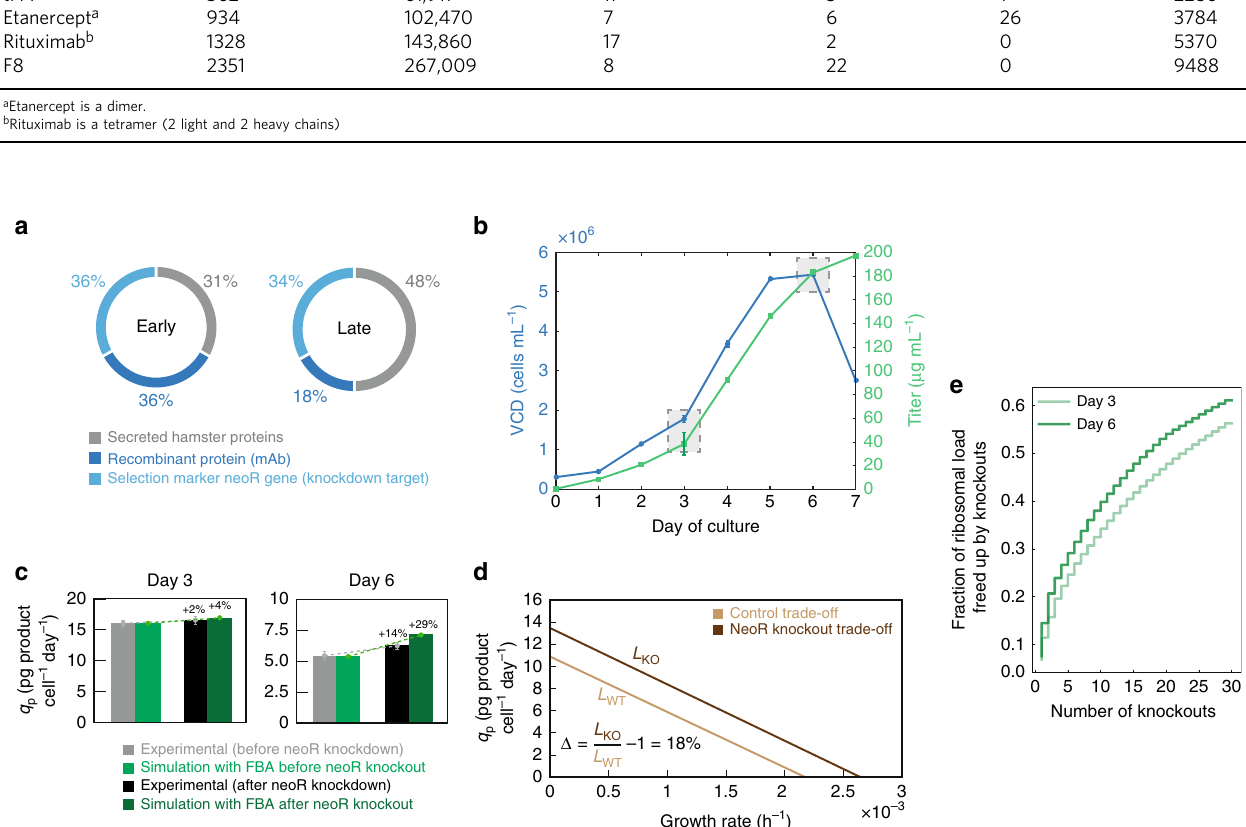
Fig. 5 iCHO2048s recapitulates experimental results of neoR knock-down in silico. a Ribosome occupancy was measured with ribosomal pro fi ling during early (left) and late (right) exponential growth phases 12 . b Time pro fi les are shown for viable cell density (VCD) and titer in experimental culture. Shaded boxes indicate the time points corresponding to early (day 3) and late (day 6) growth phases. c Flux balance analysis was used to predict speci fi c productivity ( q p ) with the iCHO2048s model before and after in silico knockout of the neoR gene. d Growth-productivity trade-offs were predicted by iCHO2048s and demonstrated a potential 18% increase after the neoR in silico knockout. The formula for calculating the trade-off improvement ( Δ ) is shown in the plot. L WT = length of trade-off curve before knockout, L KO = length of trade-off curve after knockout. e Ribosomal occupancy for all mRNA sequences bearing a signal peptide sequence were analyzed from the Kallehauge et al. 12 study and demonstrated that the top 30 secreted proteins accounted >50% of the ribosomal occupancy of secreted proteins. Error bars represent the standard deviation of three biological replicates. Source data are provided as a Source Data fi